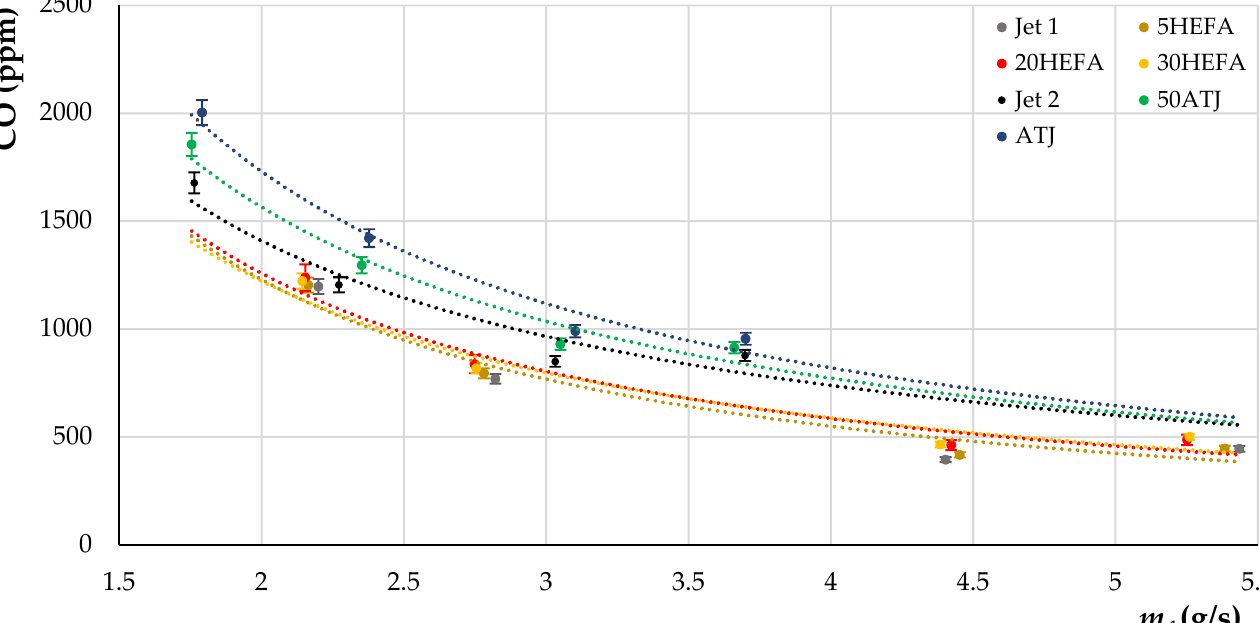
Figure 3. The relationship between CO concentration and fuel mass flow rate. Table 2. The power functions describing relationships between CO concentration in exhaust gases and fuel mass flow rate.